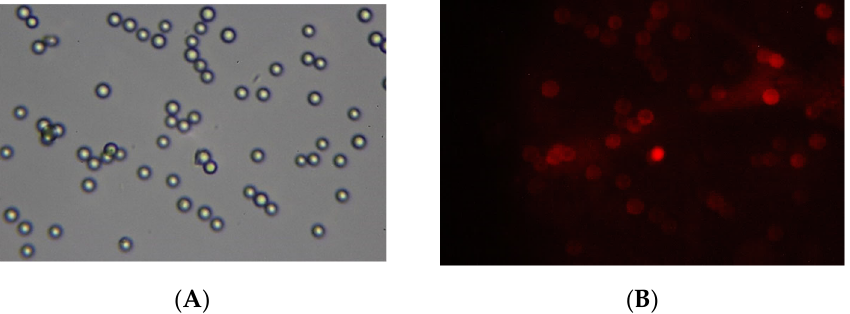
Figure 9. Images of lipid ‐ bilayer ‐ covered BSLMs incubated with NIPAM ‐ PAA ‐ FeO(OH)–DOX in the presence of a magnet. Optical channel ( A ) and fluorescent channel ( B ).